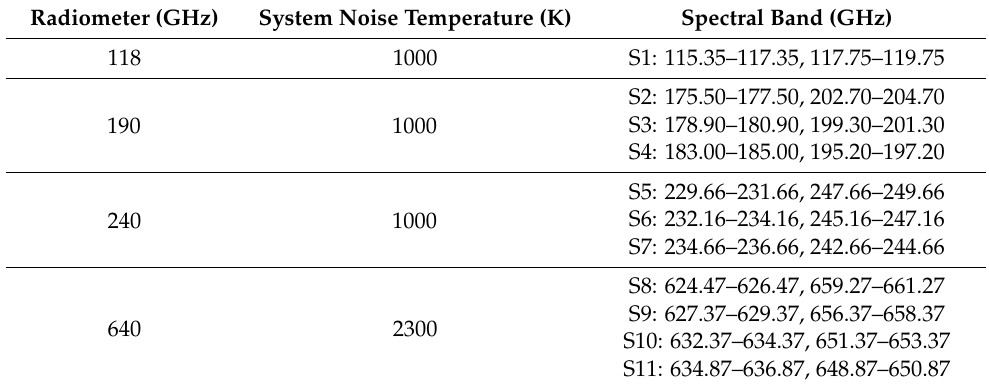
Table 3. The parameters of